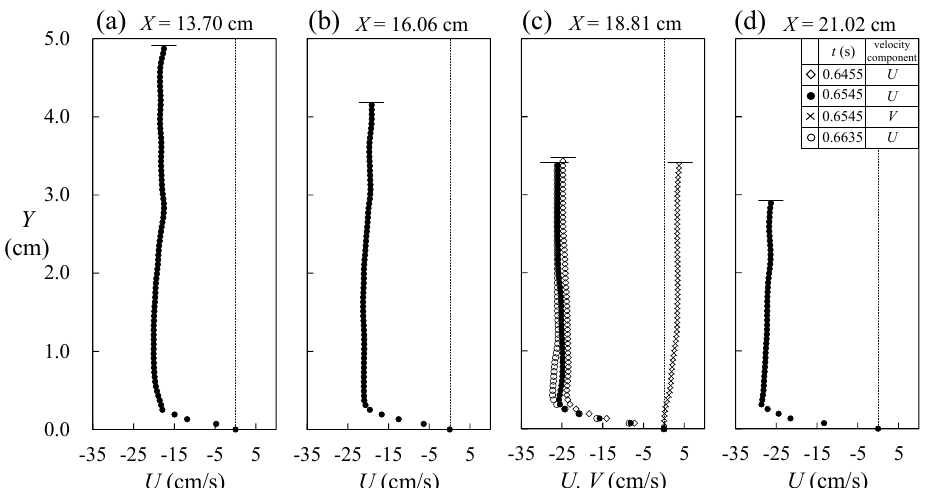
Figure 8. ( a – d ) The velocity profiles, U ( Y ), obtained at four different shoreward distances, X , as marked in Figure 6b each with inclined line having a circled number (from ① to ④ ). Two additional velocity profiles U ( Y ) for t = 0.6455 and 0.6635 s as well as one velocity profile V ( Y ) for t = 0.6545 s are also included in ( c ). Note that selection of the four shoreward distances for these velocity profiles aims to highlight the variation trend of the uniform velocity on the onshore and offshore sides of X = 18.81 cm, at which the incipient flow separation occurs at later time t = 0.9210 s. As seen from Table A1 in Appendix A, the four leftmost columns list the values of the heights Y , the data of the three ensemble-averaged velocity profiles U ( Y ) at t = 0.6455, 0.6545 and 0.6635 s. In addition, the corresponding values of the local acceleration A l ( Y ), obtained with Δ t = 0.0090 s using central difference scheme, are tabulated in the sixth column, show very drastic variation in the magnitudes at different heights. The depth-averaged value of the local acceleration is correspondingly presented with A l,da = − 116.8 cm/s 2 at the bottom of the sixth column. Similarly, the values of A l,da ( t ) at different times can be obtained for X = 18.81 cm. For example, A l,da = − 152.2, − 146.2, − 66.7 and − 98.7 cm/s 2 at t = 0.6365, 0.6455, 0.6635 and 0.6725 s, respectively. A symmetric five-point smoothing scheme with different weightings (i.e., 1/6 for the front two, 1/3 for the targeted one and 1/6 for the rear two) is then employed in time domain. Accordingly, the smoothed value of the local acceleration at t = 0.6545 s is calculated to be A l,s = − 116.3 cm/s 2 .